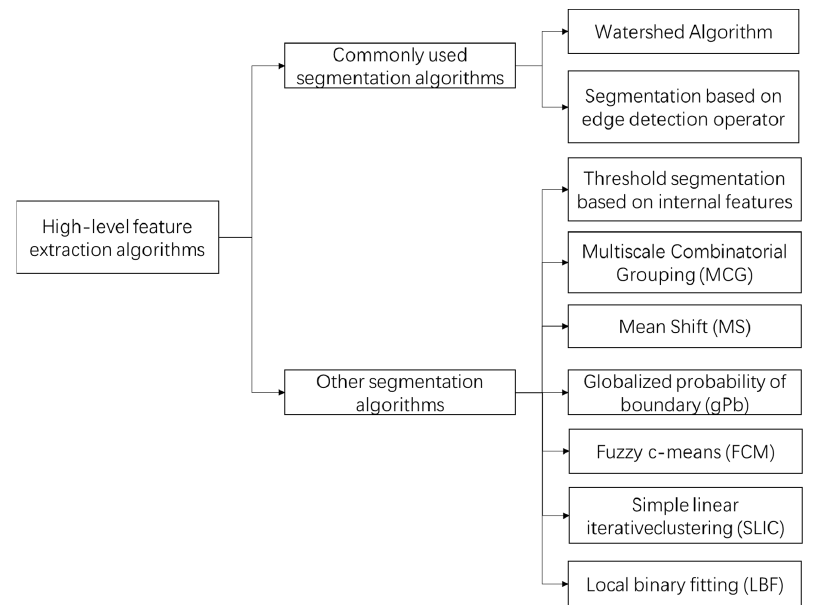
Figure 4. Classification of high-level feature extraction algorithms.